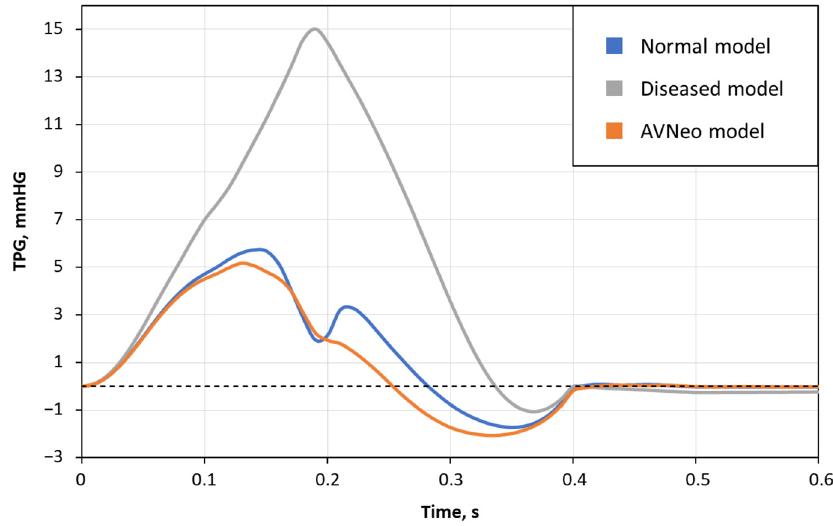
Figure 5. Transvalvular pressure gradient (TPG) for healthy, calcified, and neo-cuspidated aortic valves.